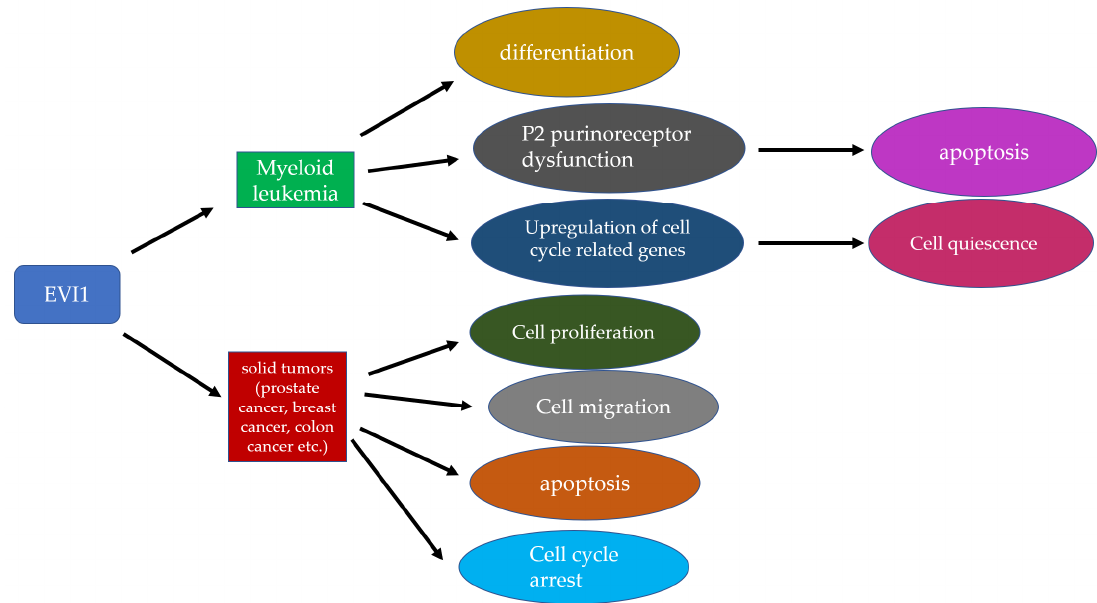
Figure 3. Functions of EVI1 in leukemia and solid tumors. EVI1 regulates differentiation, apoptosis and cell quiescence in leukemia and cell proliferation, migration, apoptosis and cell cycle in solid tumors.